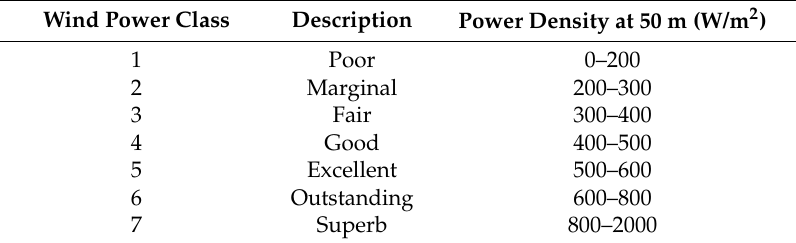
Table 2. Wind power class [27].